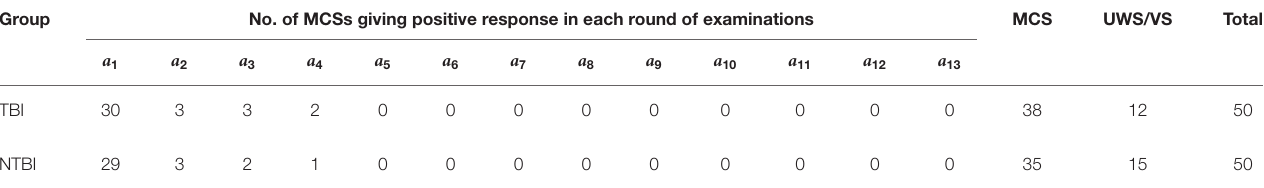
TABLE 3 | The data collected from the 13 rounds of successive examinations. Group No. of MCSs giving positive response in each round of